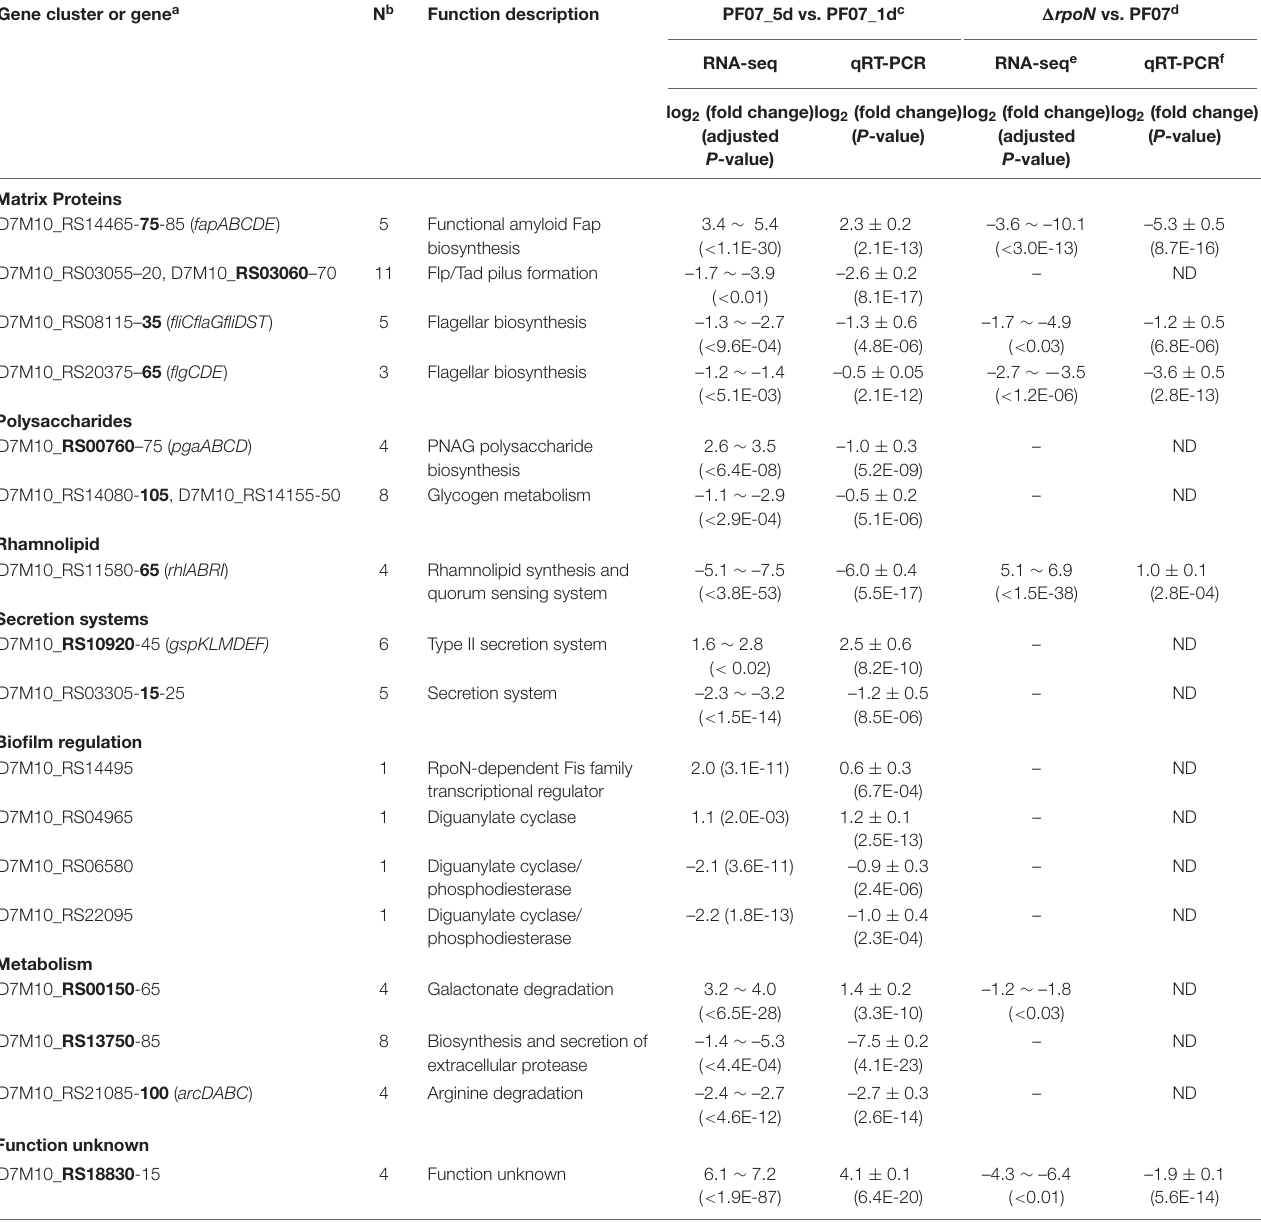
TABLE 2 | Representative DEGs from RNA-seq analysis and qRT-PCR verification. Gene cluster or gene